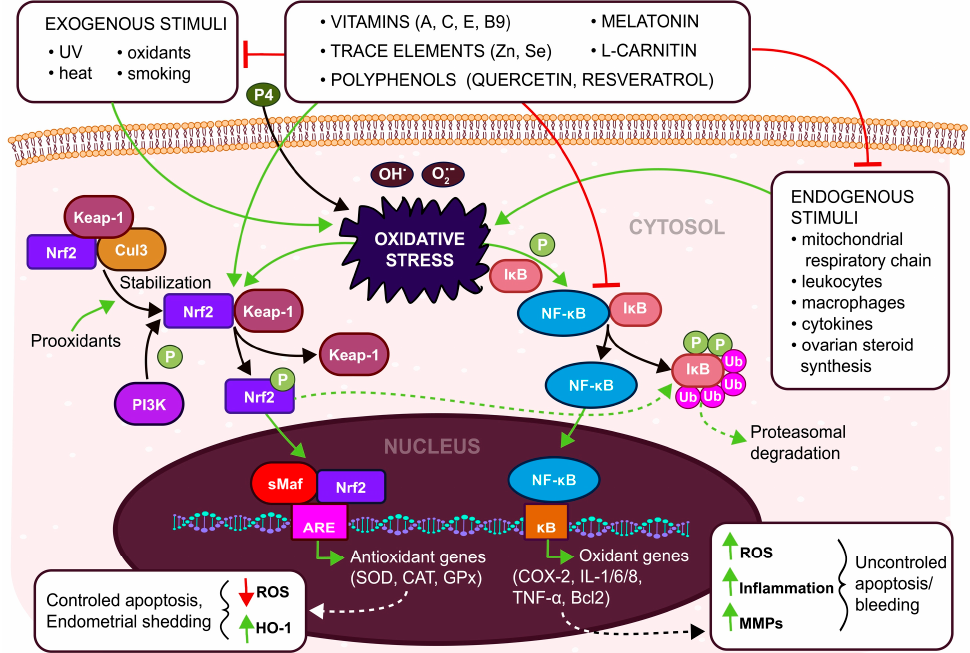
Figure 1. Oxidative stress (OS) is a stimulant (green arrows) of two main antioxidant signaling pathways-Nrf2 and NF- κ B. Nrf2 signaling is involved in the expression of antioxidant enzymes, minimizing the effect of OS. NF- κ B signaling is involved in the expression of genes for cells surviving under OS. Exogenic antioxidants (vitamins, trace elements, polyphenols, etc.) activate Nrf2 signaling and inhibit (red lines) the NF- κ B pathway and eliminate exogenous as well as endogenous stimuli of OS. (Nrf2—Nuclear factor erythroid 2-related factor 2, Keap-1—Kelch-like ECH-associated Protein 1, Cul3—cullin protein 3, PI3K—Phosphoinositide 3-kinase, P—phosphate, NF- κ B—Nuclear factor kappa-light-chain-enhancer of activated B cells, I κ B—inhibitor of nuclear factor kappa B, sMaf—musculoaponeurotic fibrosarcoma, ARE—Antioxidant responsive el- ement, κ B— κ B DNA binding, SOD—Superoxide dismutase, CAT—Catalase, GPx—Glutathione peroxidase, COX-2—Cyclooxygenase 2, IL-1/6/8—Interleutkin 1/6/8, TNF- α —Tumor necrosis factor α , Bcl2—B-cell lymphoma-2, ROS—reactive Oxygen Species, HO-1—Heme Oxygenase 1, MMPs—Matrix metalloproteinases,